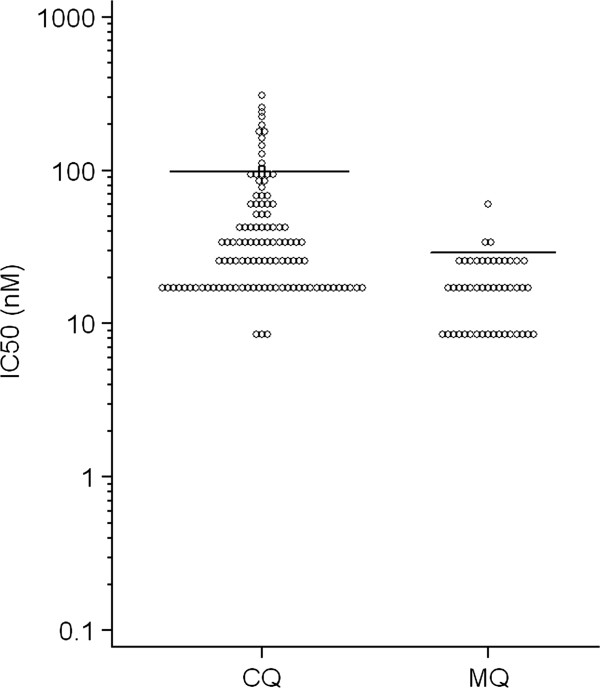
Distribution of IC50’s (nM) among 112 Plasmodium vivax isolates from Manaus cultured in the presence of various concentrations of chloroquine (CQ) or mefloquine (MQ). The horizontal bars represent the likely thresholds between sensitivity and resistance.